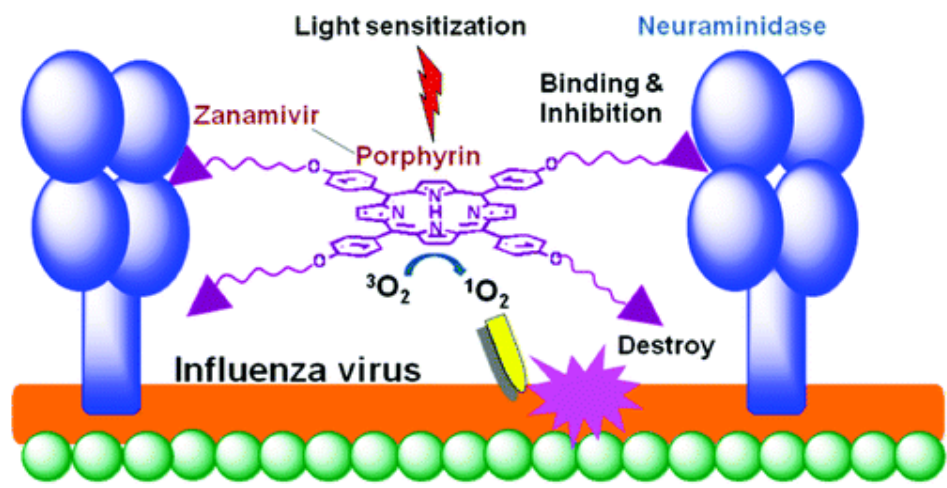
Figure 6. Schematic representation of the life cycle of an influenza virus [46,47].